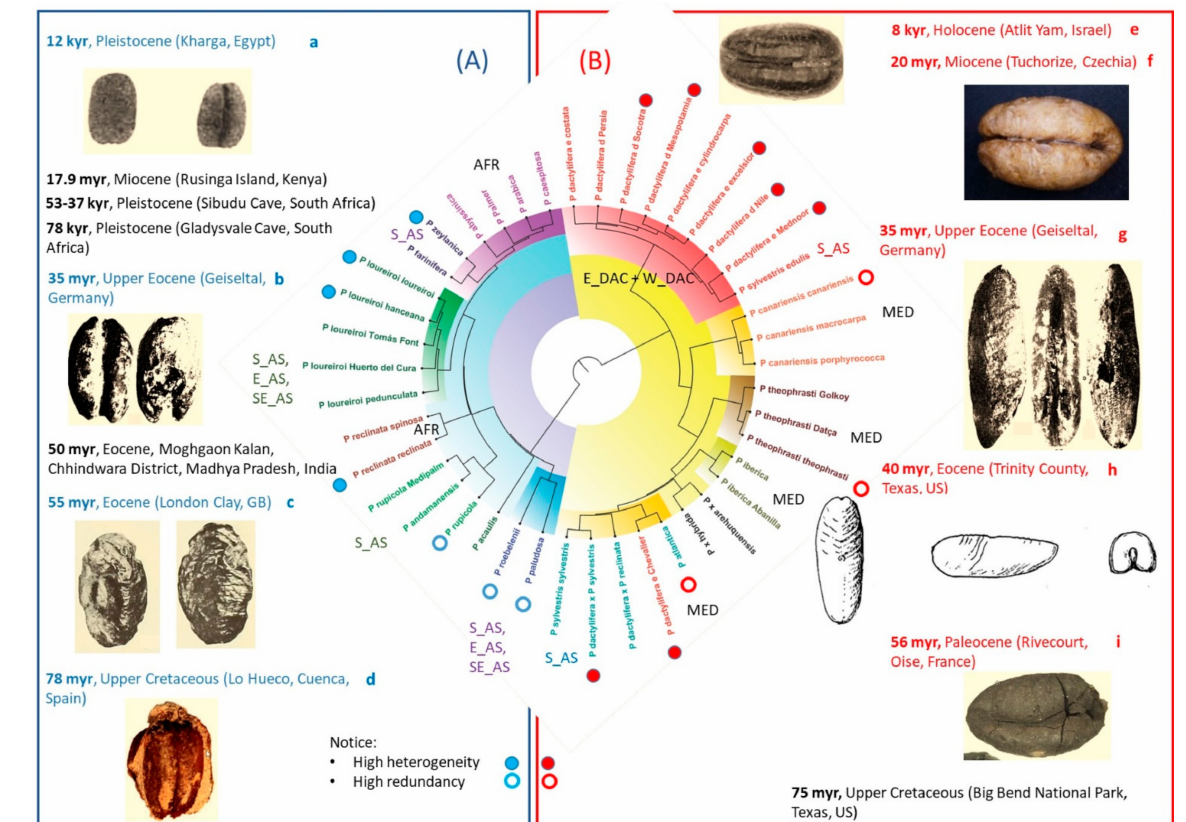
Figure 10. Phoenix OTUs and fossil Phoenix seeds. ( A ) Eastern group of Phoenix species; ( B ) Western group of Phoenix with, notably, P. dactylifera. a–d. Fossil seeds of Phoenix morphologically similar to those of species in the eastern group (A) of species. e–i. Fossil seeds of Phoenix morphologically similar to those of species in the western (B) species group. Abbreviations for the geographical groups: E_DAC: North Africa and West Asia P. dactylifera . W_DAC: North Africa and